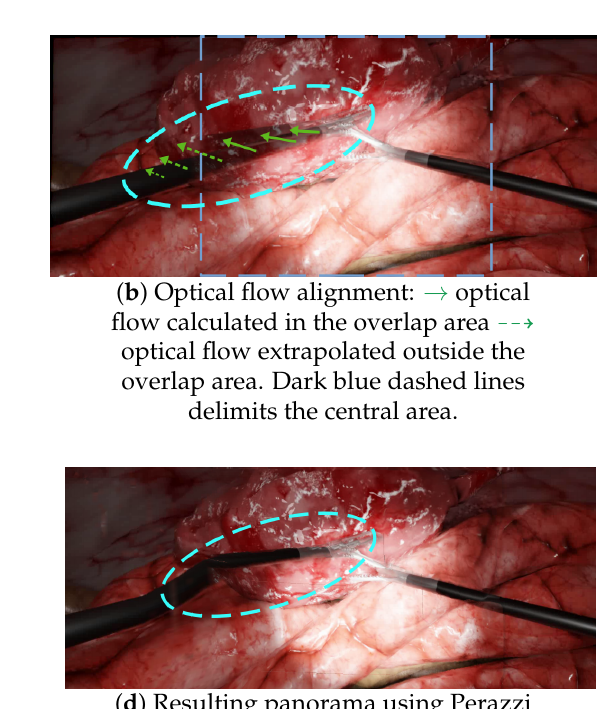
( c ) Full optical flow map after ( d ) Resulting panorama using Perazzi extrapolation algorithm. Figure 10. Illustrations of some of the failures of the non-mesh-based method Perazzi. ( a ) The panorama obtained after the pre-alignment step using global homography, with a duplicated left- hand forceps. ( b ) A schematic of the optical flow, computed in the overlap area and extrapolated to outer areas. ( c ) The full optical flow map after “weighted warp” extrapolation. ( d ) The resulting panorama after applying the optical flow map of ( c ) to the pre-aligned images ( a